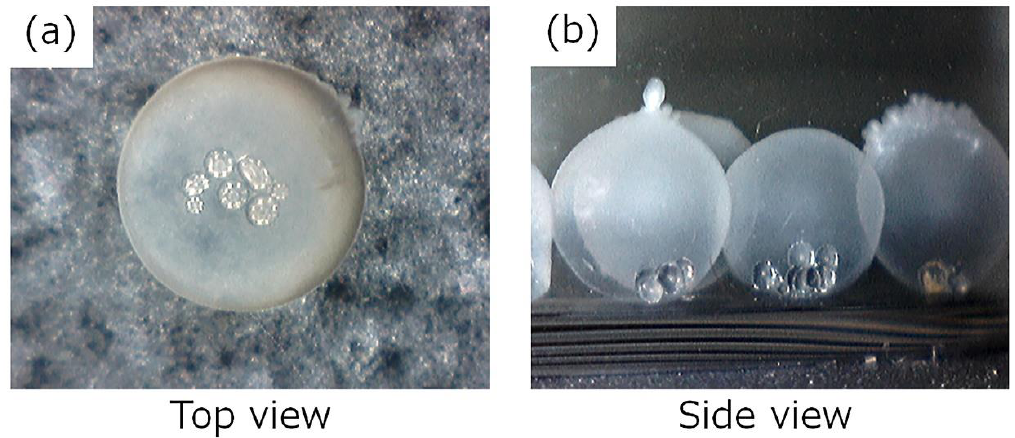
Figure 3. Photographs of HSBC-gel-encapsulated glass beads: ( a ) top view and ( b ) side view.